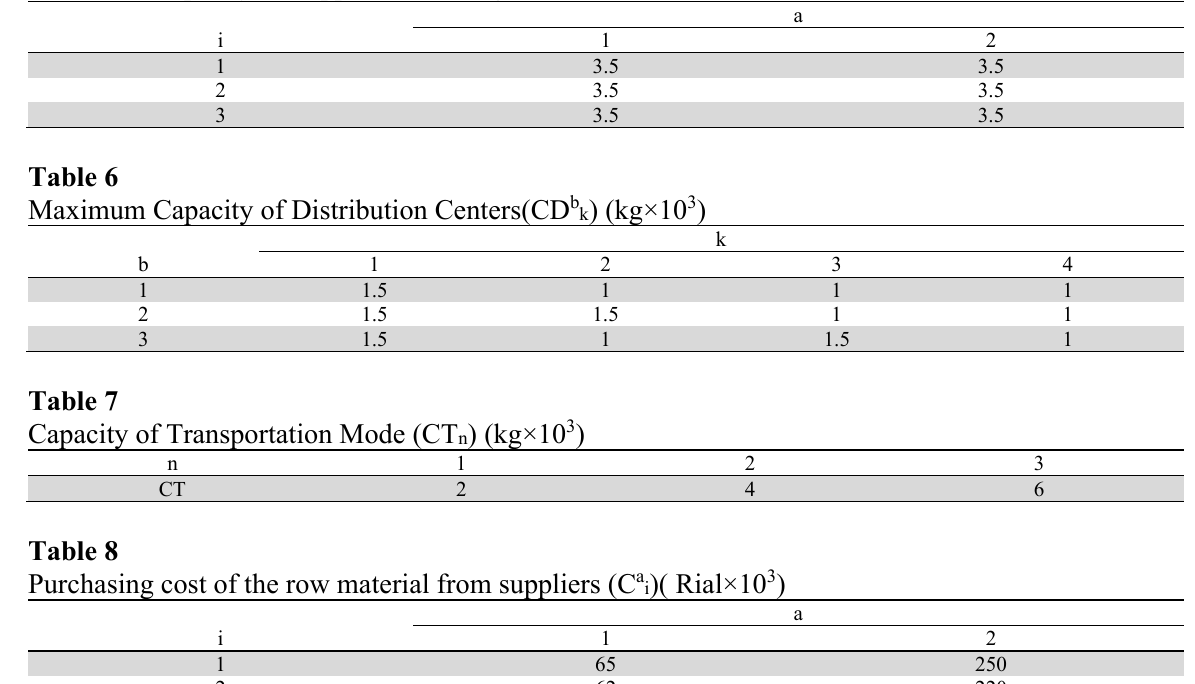
Maximum Capacity of Supplier (CS a i ) (kg×10 3 )